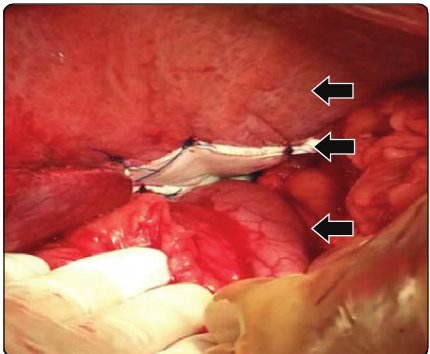
Figure 4: Mesh reparation (photo taken from the left of the patient. Arrows point at, starting from top, the diaphragm, the mesh, and the stomach back into the